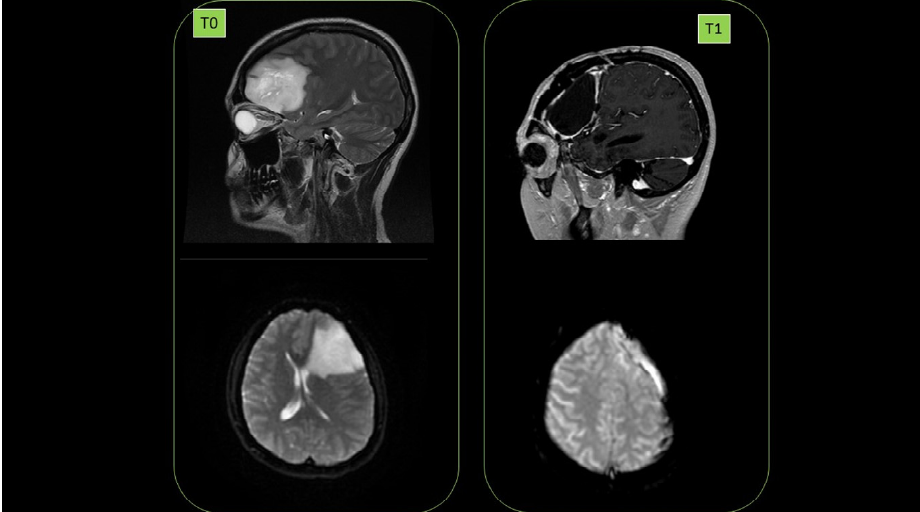
Figure 17. Disappearance of radioresistant brain glioblastoma (T0) after 1 year of HOO